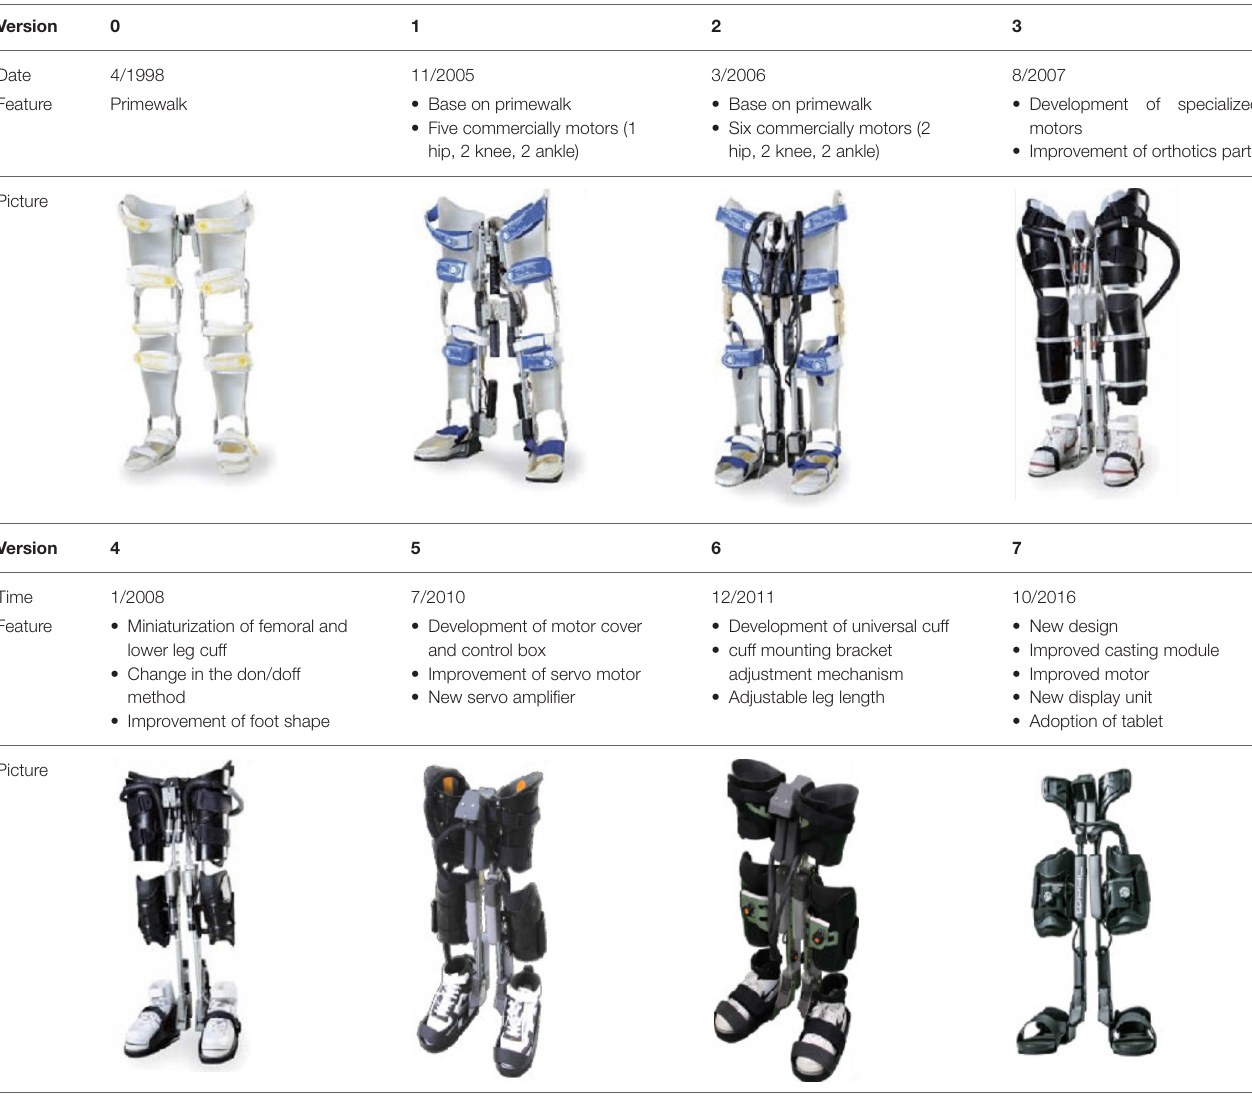
TABLE 1 | Development history of the Wearable Power-Assist Locomotor